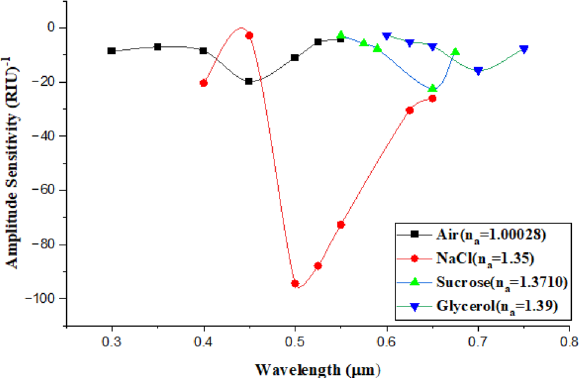
Figure 21. Presents the amplitude sensitivity of air, NaCl-DI water, sucrose-DI water, and glycerol-DI water as a function of